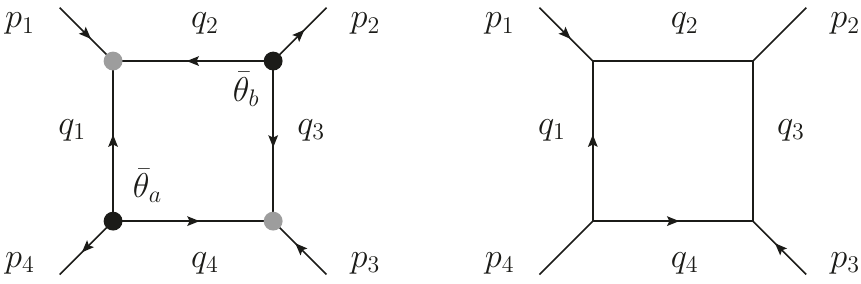
(cid:22)(cid:8)(1)(cid:9)(2)(cid:22)(cid:8)(3)(cid:9)(4) Figure 5 . Left: one-loop superamplitude . The loop propagator momenta are h i denoted by q 1 ; : : : ; q 4 and their direction is chosen to coincide with chirality. All external momenta p 1 ; : : : ; p 4 are in(cid:13)owing. Right: the corresponding bosonic integral in eq. (3.33) is a zero-mass box with magic numerator. Arrows denote fermionic propagators and fermionic external